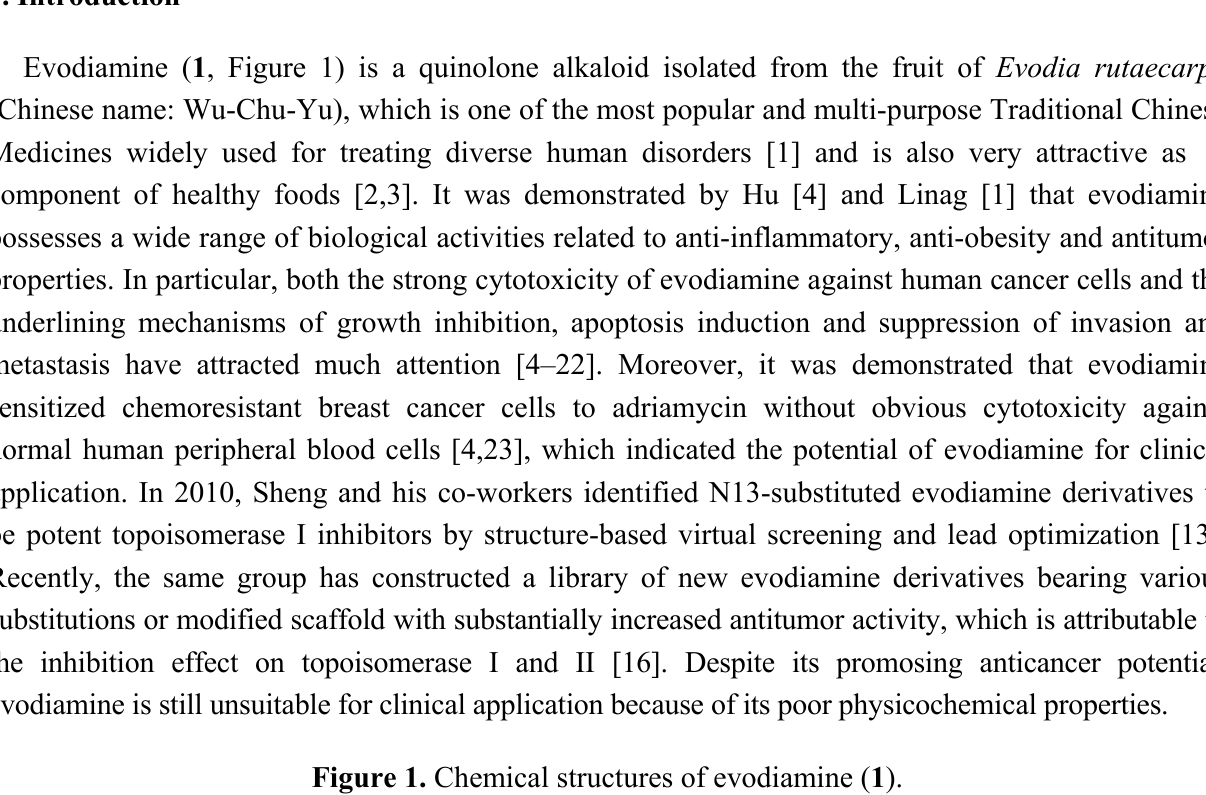
Figure 1. Chemical structures of evodiamine ( 1